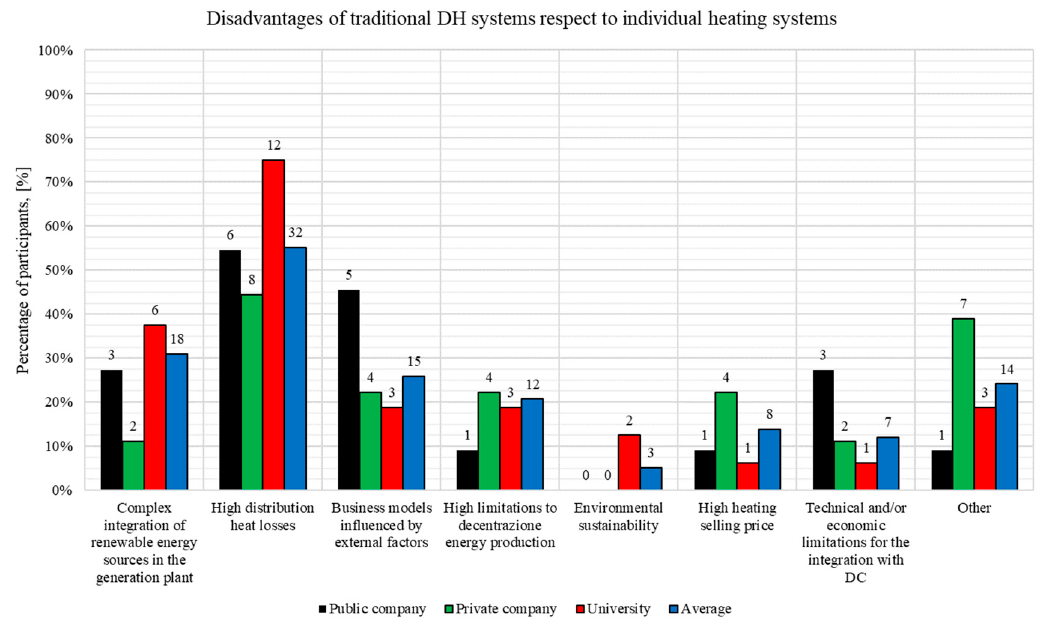
Figure 18. Disadvantages of traditional DH systems with respect to individual heating systems as a function of the organization type.